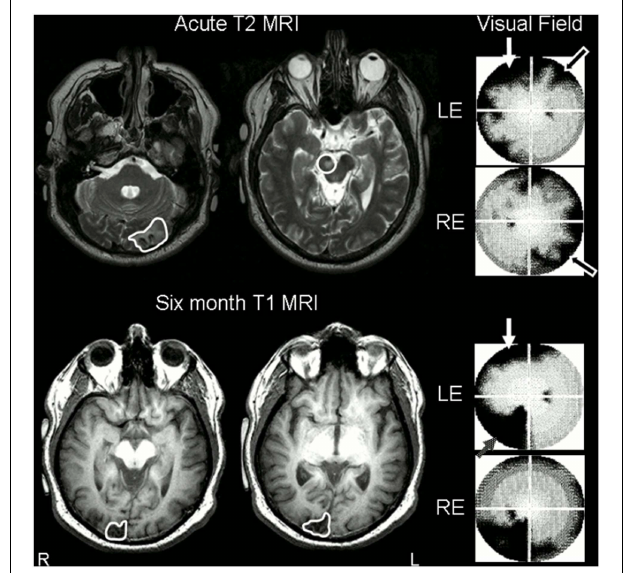
FIGURE 1 | Stroke sites and corresponding visual field deficits on perimetry. Top Row: day 8 T2-weighted MRI scan, axial slices (radiological convention, so images are flipped) through occipital cortex showing left acute occipital lesion and demonstrating midbrain lesion (traced or circled in white). Despite the fact that his midbrain lesion was right-sided, the patient had persistent left ptosis, with left lid artifact present on perimetry (white arrow). T2 images are shown as subacute ischemic lesions are difficult to see on T1 images. His right partial homonymous visual deficit can be seen on his perimetric visual field maps (black arrows). Note that perimetric tests were 90 ◦ visual field tests. Bottom row: repeat MRI at 6 months, axial T1-weighted slices through occipital lobes, revealed interval infarction in the right occipital pole (traced in white). Lid artifact still present from ptosis (white arrow), but perimetry revealed almost complete resolution of right homonymous deficit despite interval development of partial left inferior quadrantanopia (gray speckled arrow). LE, left eye; RE, right